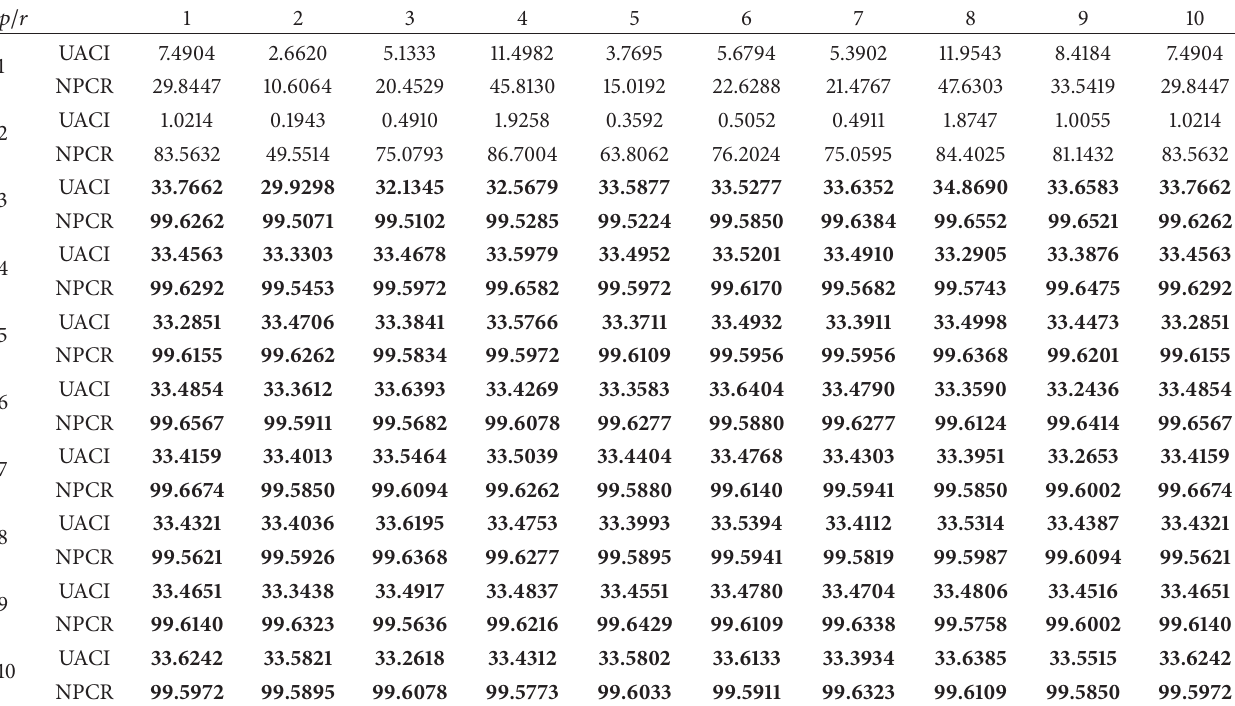
Table 13: Calculated UACI and NPCR for different combinations of 𝑝 and 𝑟 while 𝑞 = 1 for